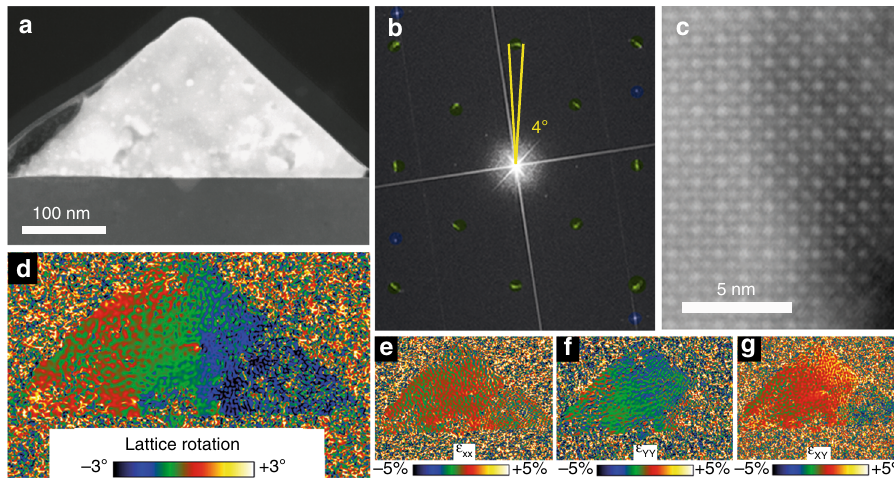
Fig. 5 Atomic scale imaging and geometric phase analysis (GPA) of surface-guided CsPbBr 3 nanowires. ( a ) Large fi eld-of-view, high-resolution STEM image of the entire cross-section. ( b ) Fast Fourier transform of the entire cross-section revealing arcs instead of spots for CsPbBr 3 spacings (green), and sharp single spots for sapphire spacings (blue). ( c ) High magni fi cation image of the CsPbBr 3 lattice. ( d ) GPA generated lattice rotation map and maps for in-plane ( e ), out-of-plane ( f ), and shared ( g ) strain.